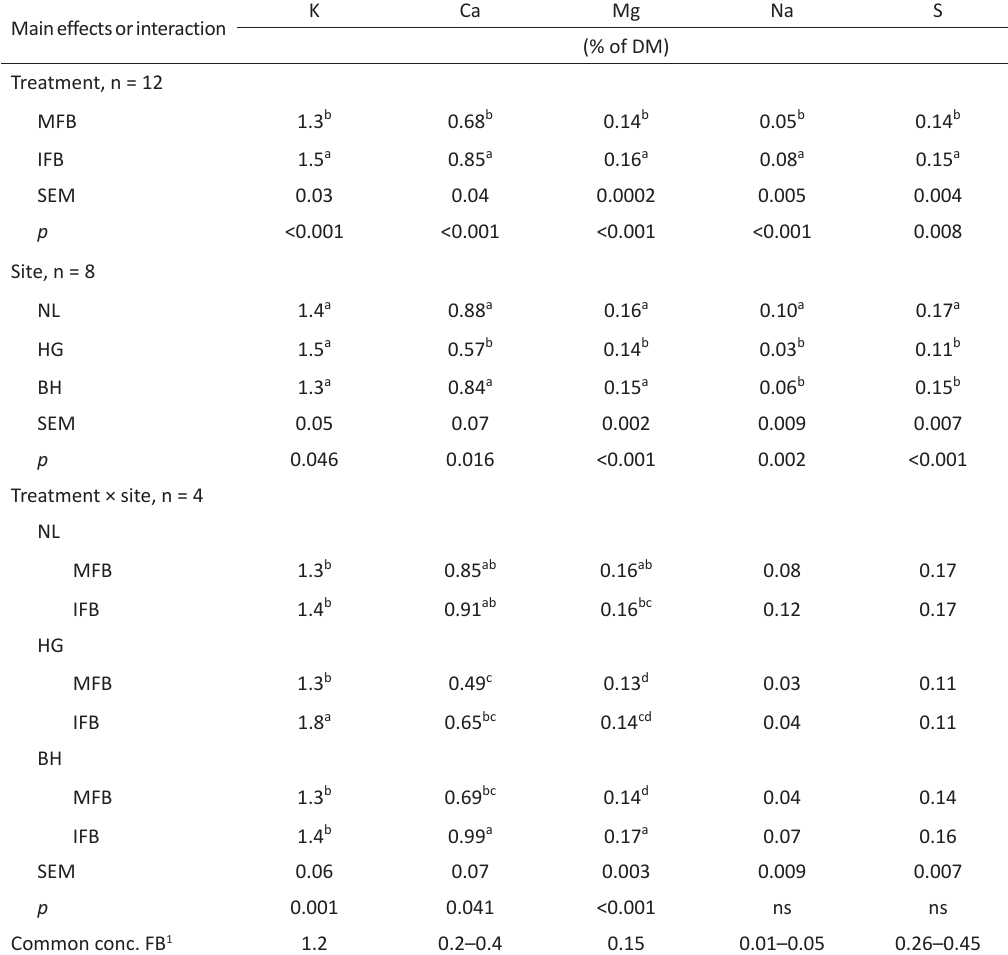
Table 2. Concentrations of macro nutrients in intercropped and monocropped faba bean in three field experiments Main effects or